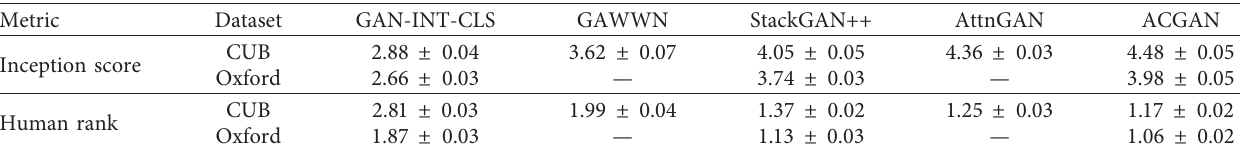
Table 2: Inception scores and human rank scores for the five GAN models on the CUB and Oxford datasets.